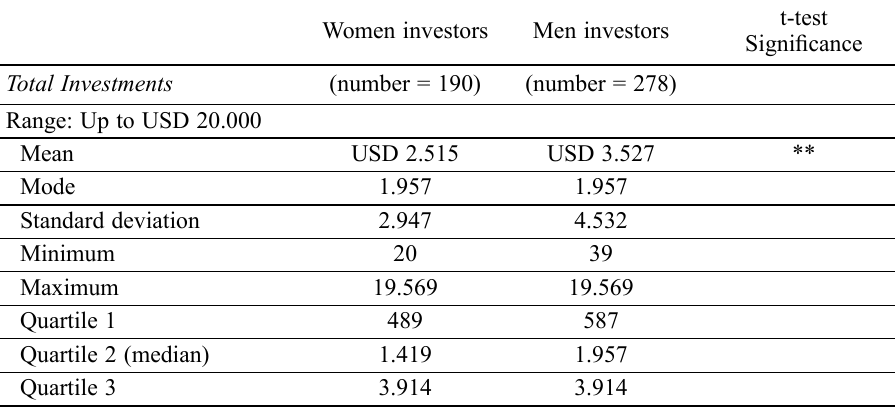
Table 4. Gender differences in the size of the